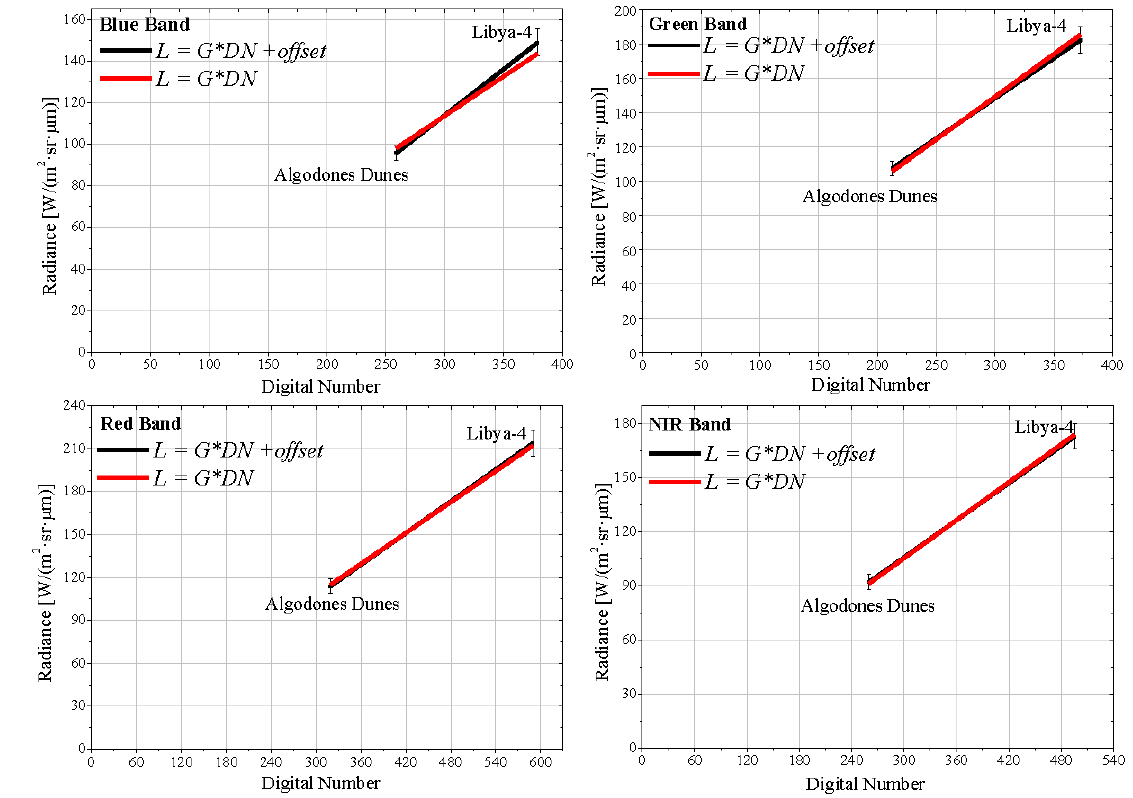
Figure 10. Absolute radiometric calibration of WFI/CBERS-4.